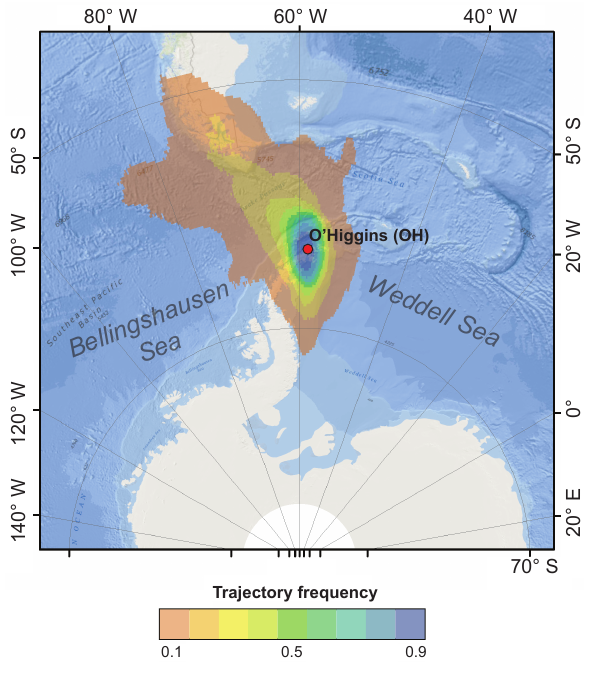
Figure 5. Frequency distribution map of the main transport paths of air masses approaching the northern Antarctic Peninsula (AP). Translucent red colours represent the lowest frequency and blue colours the higher frequency. In general, most of the air masses ar- riving at the AP are coming from the Bellingshausen Sea and the South Pacific Ocean.